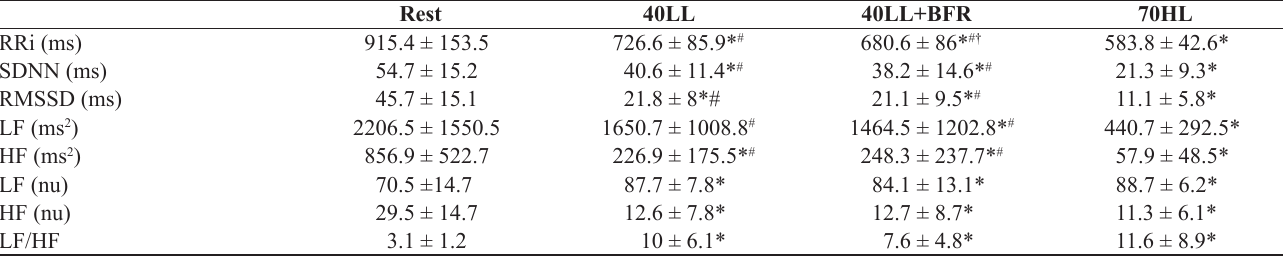
Table 3. Mean and SD of time and frequency domain indices of heart rate variability at rest and in the 5-10 th min of recovery after constant load aerobic exercise for each experimental condition. Rest 40LL 40LL+BFR